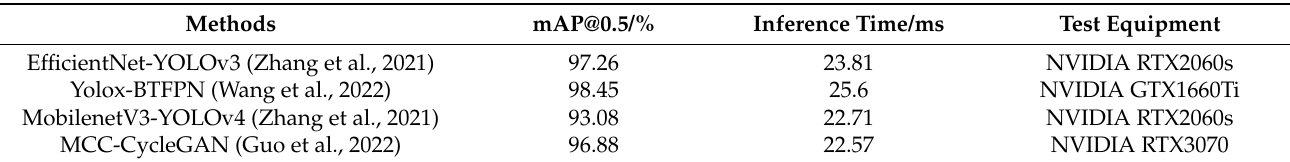
Table 1. Summary of the detection effect of some